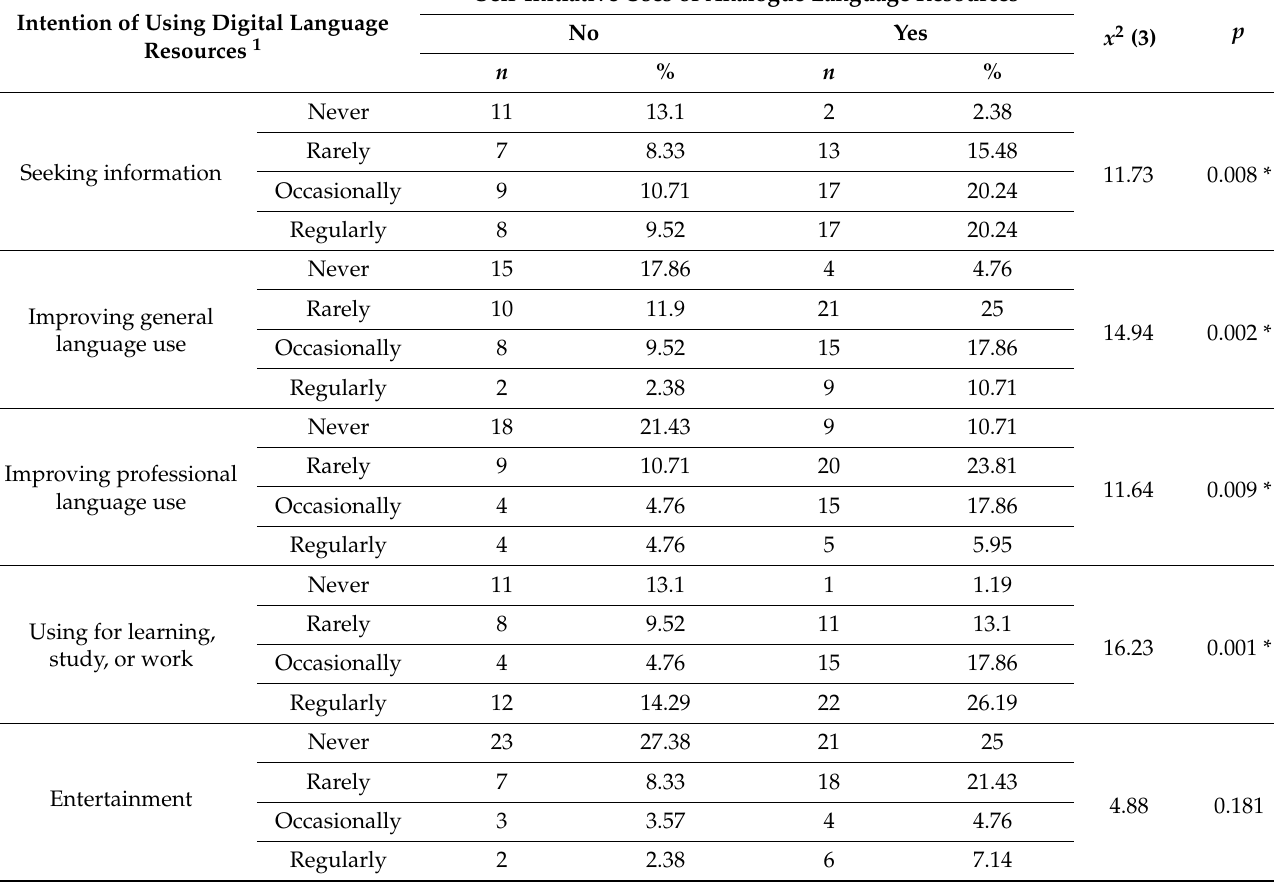
Table 2. Chi-square comparison table of participants’ self-initiative use and non-use of analogue language resources with various types of